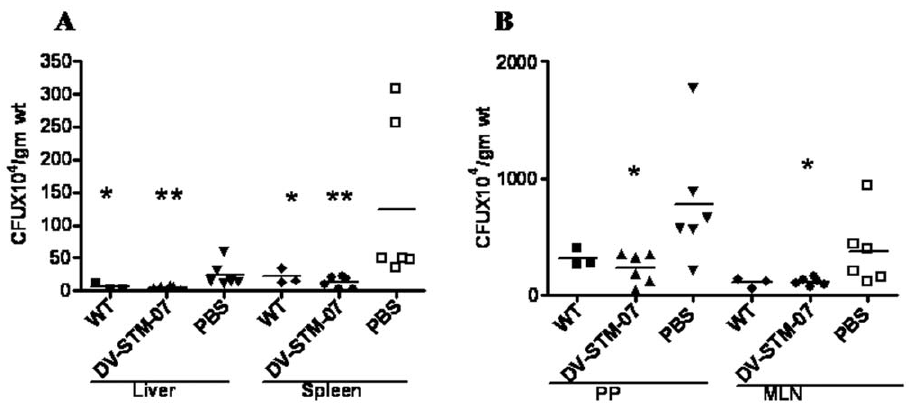
Figure 2. Protective immunity is transmitted to the next generation. Organ CFU was performed on 5 th day post infection. Significant decrease in organ CFU was observed in liver & spleen (A) and PP & MLN (B) of pups from vaccinated mother vaccinated with single dose of 10 7 CFU/ mouse during mid pregnancy, than pups from WT and PBS control mothers. (* p , 0.05, ** p , 0.01, Mann-Whitney test) Data shows the representative of three independent experiments performed.